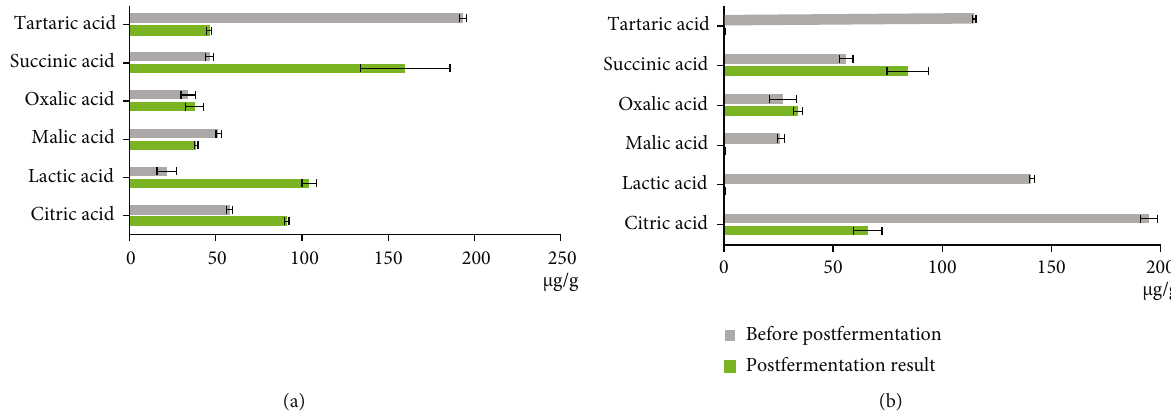
Figure 5: Impact of Eurotium cristatum INA 01267 postfermentation on the composition of organic acids in herbal teas ( μ g/g). (a) Fireweed tea. (b) Apple tree leaf tea. The presented data of the organic acid content were mean values from 3 independentextractions ± standard deviation ð SD Þ